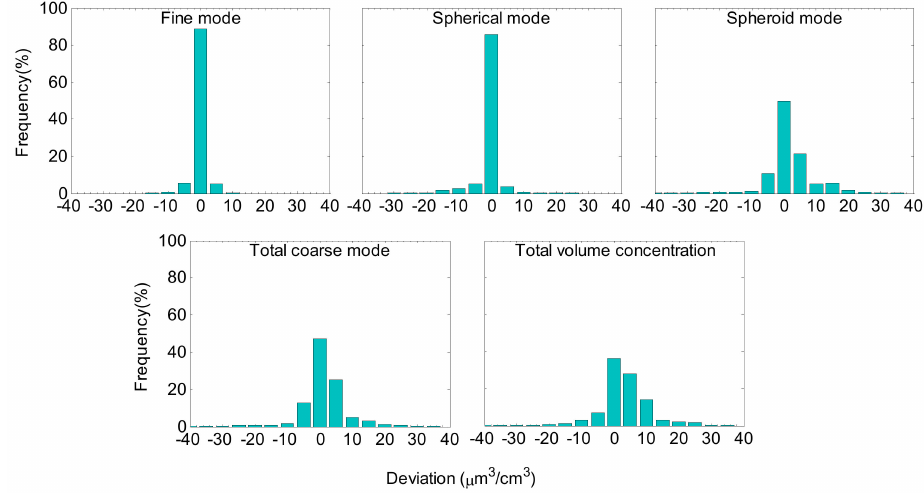
Figure 5. Histogram of the frequency distribution of the deviations for the whole dataset corresponding to summer 2012. Deviations were obtained by subsctracting the profiles from Granada above 1820 m a.s.l., to the profiles retrieved from Cerro Poyos at every height level (15 m vertical